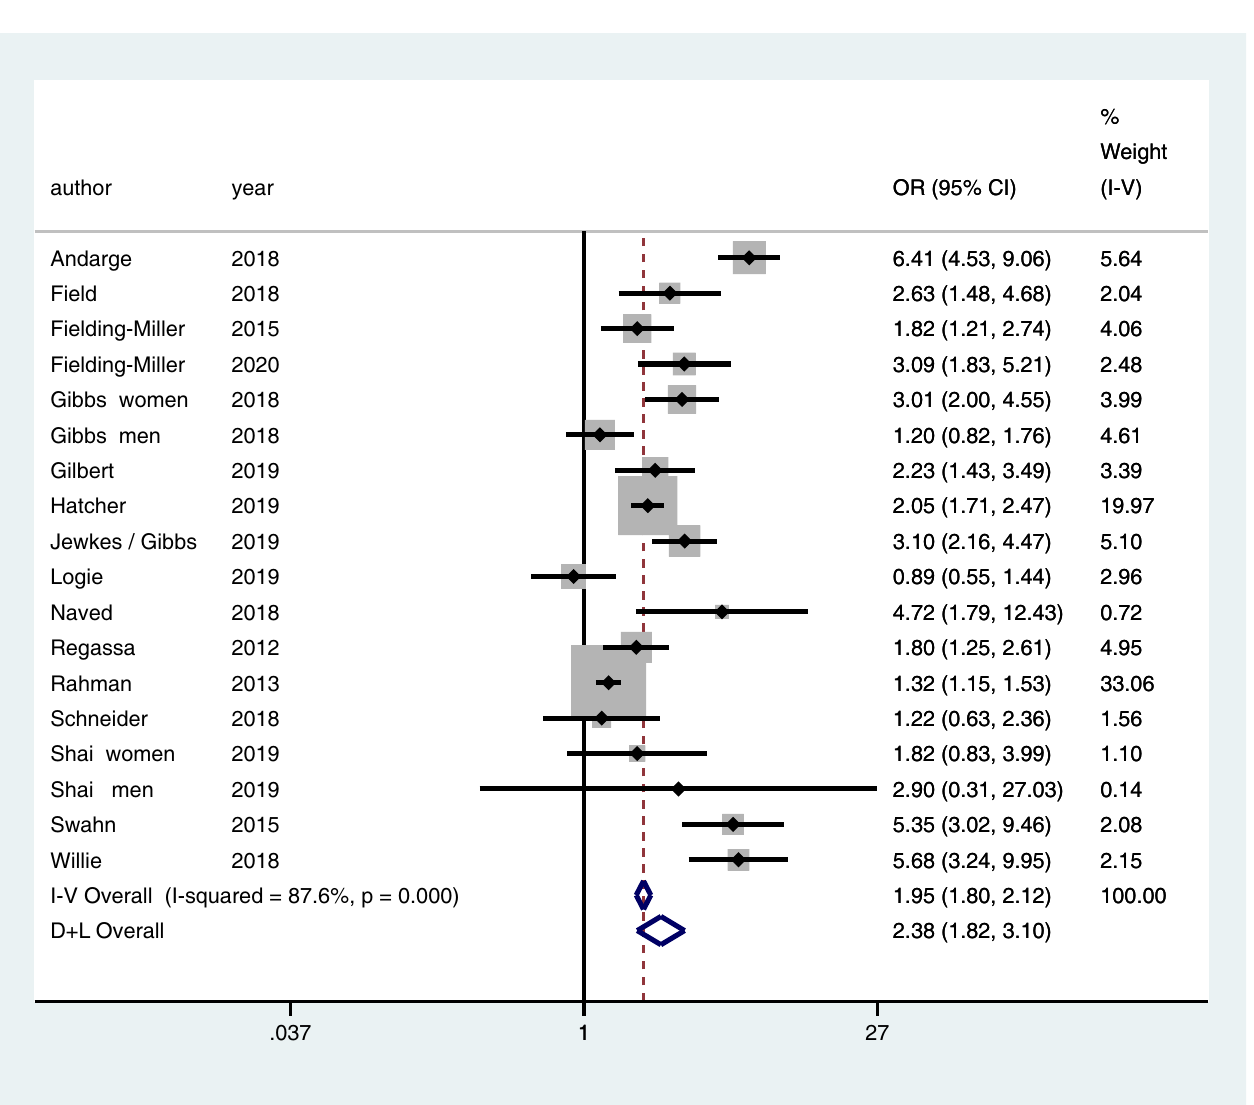
Fig 2. Meta-analysis of cross-sectional studies of relationship between food security and violence against women and girls.